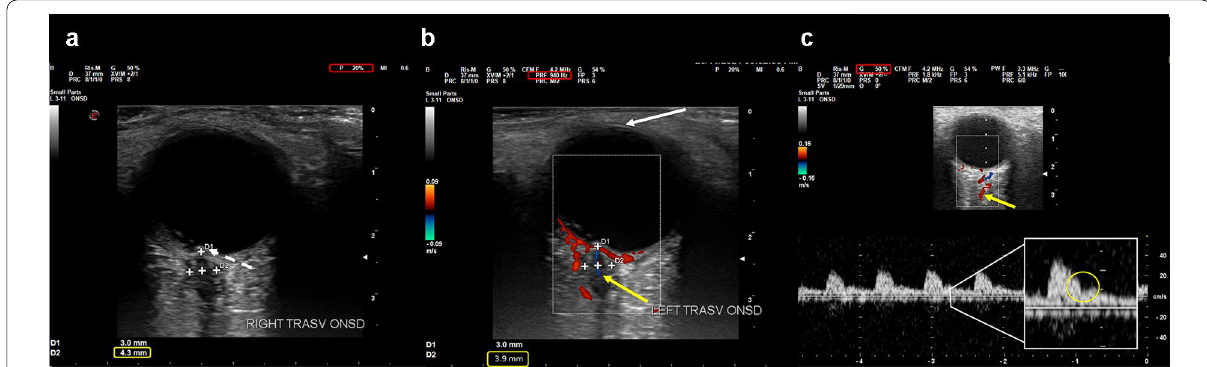
Fig.1 Three ultrasound images of the eyeball and optic nerve with sheath, enriched by the parameters/landmarks highlighted in CLOSED protocol. a B-mode image in gray-scale: dashed white arrow points to the optic disc, in yellow window 4.3 mm ONSD measurement, in red window acoustic power output 20%; b same image but with color-mode: white arrow points to the lens, in yellow window 3.9 mm ONSD measurement, in red = window PRF 940 Hz (almost 1 Kh), yellow arrow points to central retinal artery; c same image but with color-mode plus Doppler wave (at the bottom): in red window Gain 50%, yellow arrow points to ophthalmic artery, in the enlarged panel the typical nock of the ophthalmic artery